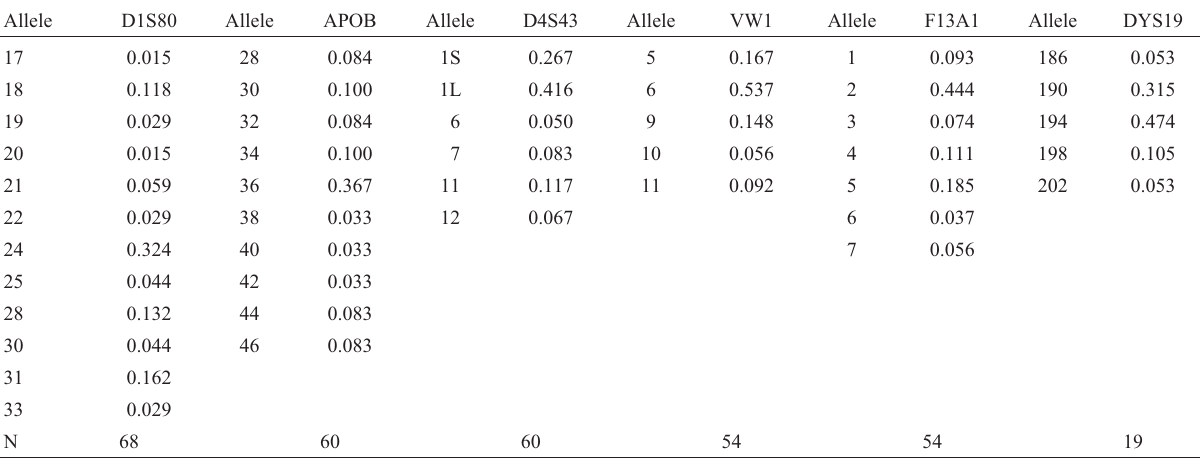
Table 2 - Allele frequency distribution for six hypervariable loci in the Curiau population. Allele